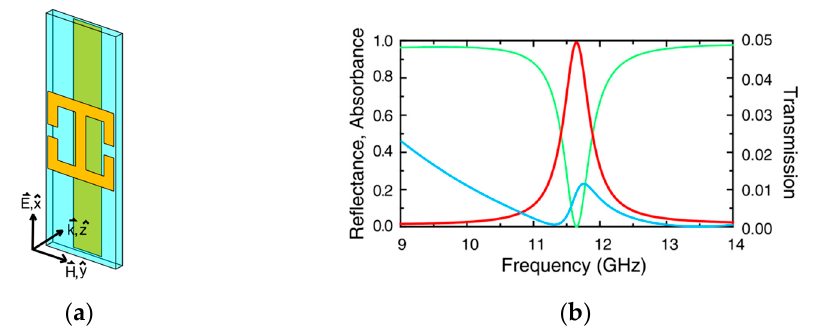
Figure 3. ( a ) The structure of the MPA unit was designed by Landy et al. [14]; ( b ) absorption, reflection, and projection curves [14].